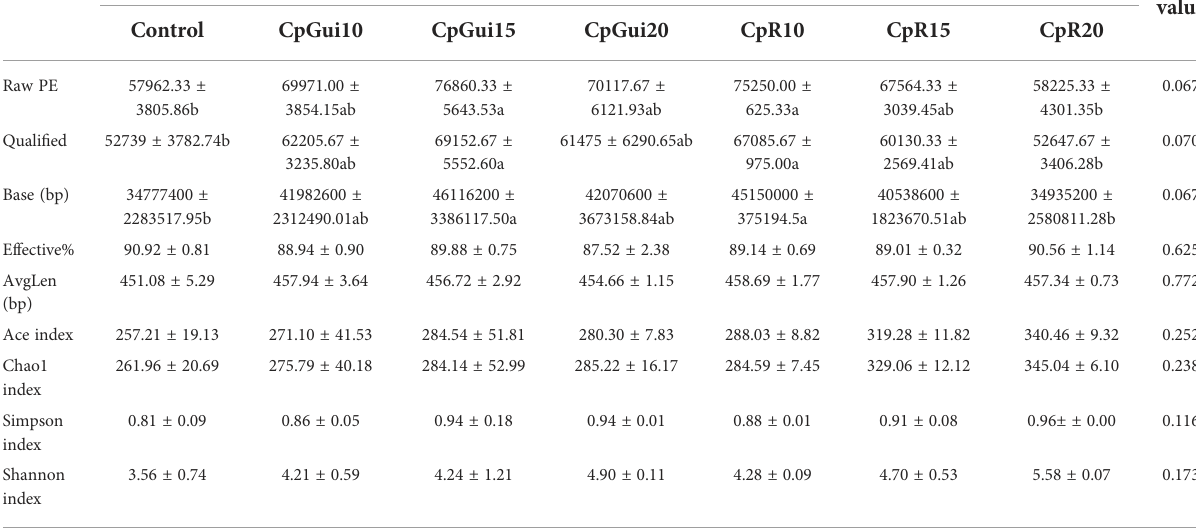
TABLE 6 Diversity and richness of bacterial sequences in the stomach of pigs fed on the various diets.